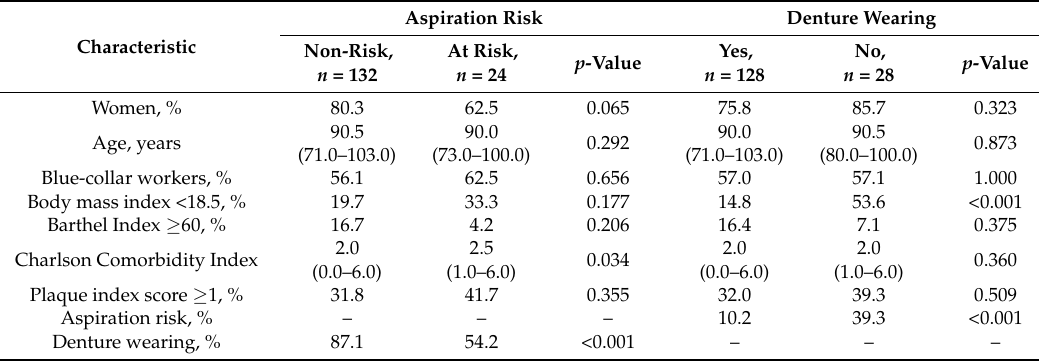
Table 1. Baseline characteristics according to aspiration risk and denture